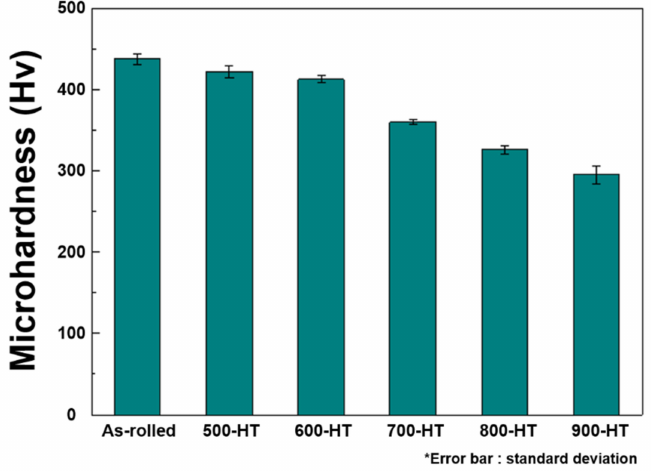
Figure 7. Evolution of microhardness with increasing heat-treatment temperature.